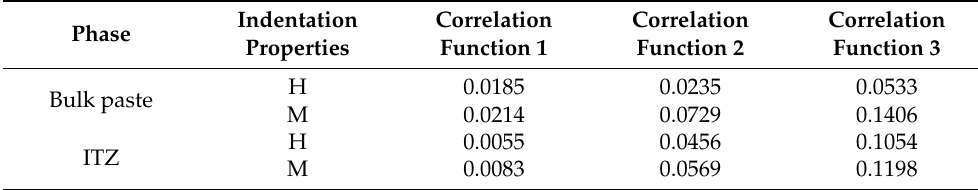
Table 5. The values of the squared 2-norm of the